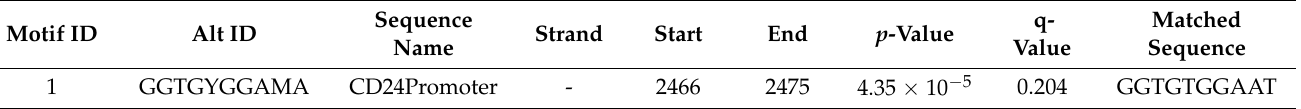
Table 1. A FIMO analysis on the position of CD24 promotor on the position − 200 to +500 was extracted from the EPD database for the STRE1 sequence (CATTTCACGG) and STRE2 sequence (GGTGYGGAMA).